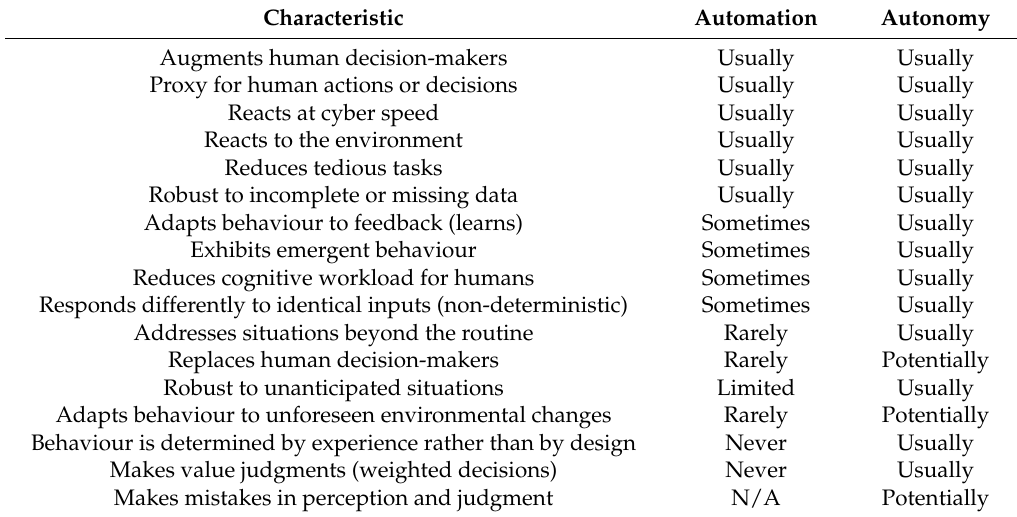
Figure 1. Contrasting automation and autonomy (adapted from Reference [10]). Table 1. Characteristics of automation and autonomy (from Reference [11]). N/A—not applicable.